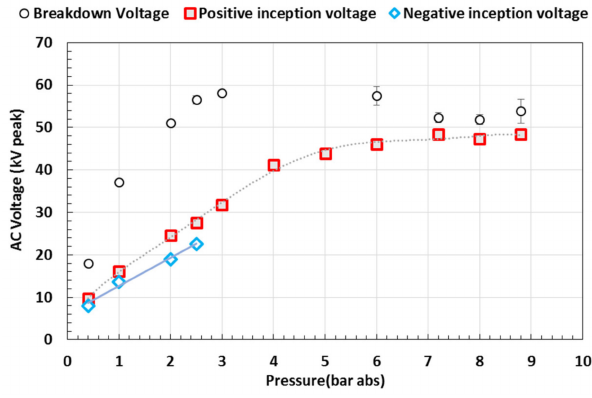
Figure 6. V mean Breakdown, positive and negative inception voltages as a function of gas pressure (4%Novec TM 4710 / 96%CO 2 , needle on HV